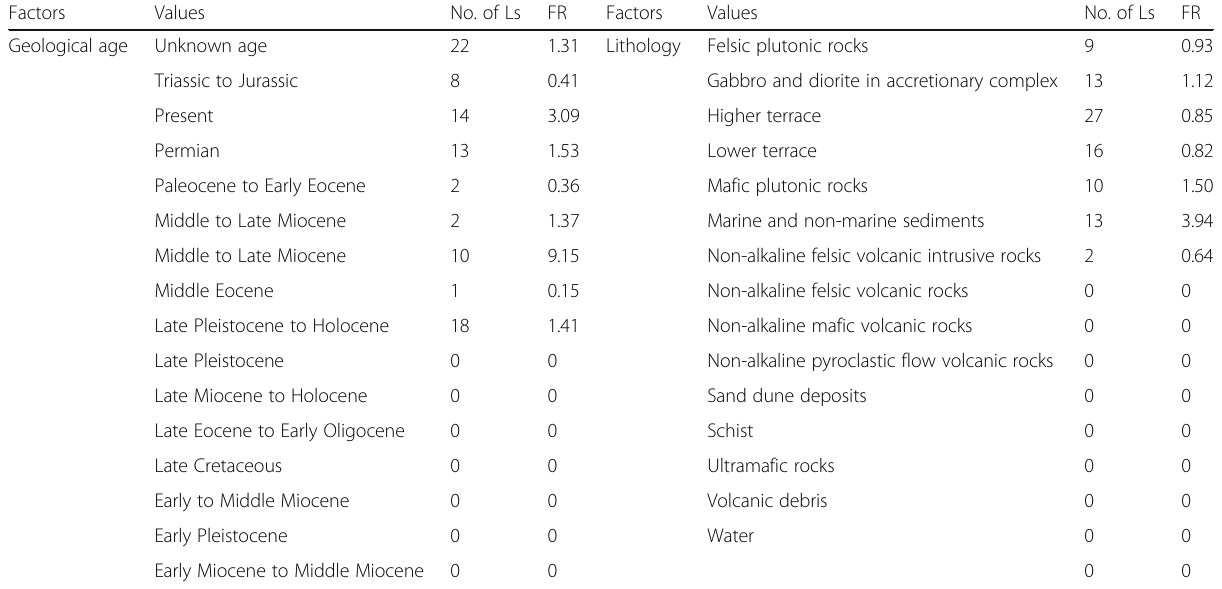
Table 3 Description and frequency ratio (FR) of geological factors in the study area Factors Values